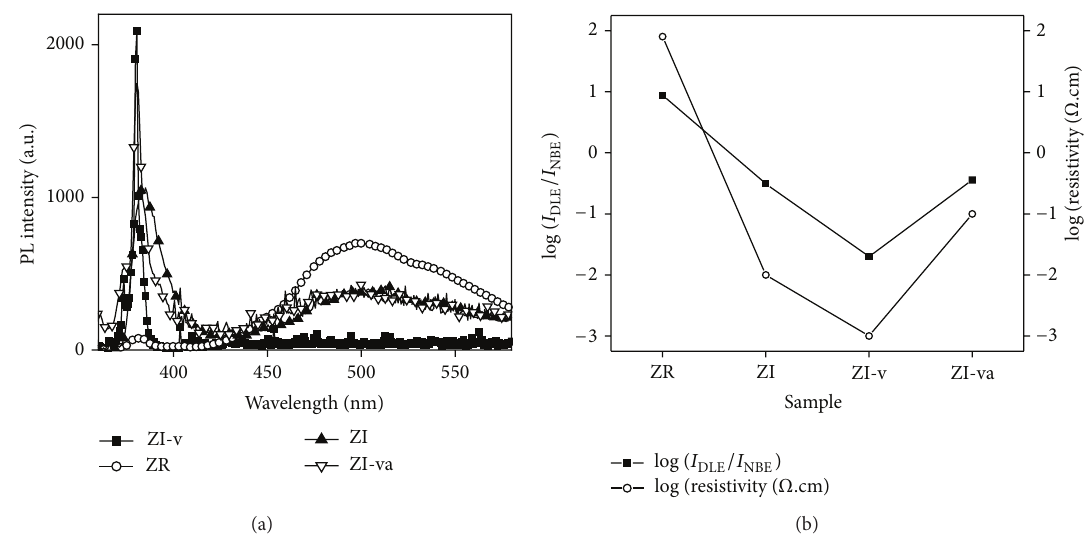
/𝐼 and resistivity for various treatments to a sample. DLE NBE